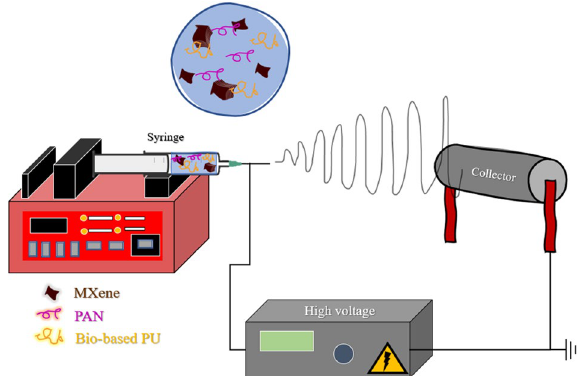
Figure 1. Schematic of the electrospinning process for the preparation of PAN/bio-based PU/Ti 3 C 2 T x MXene electrospun